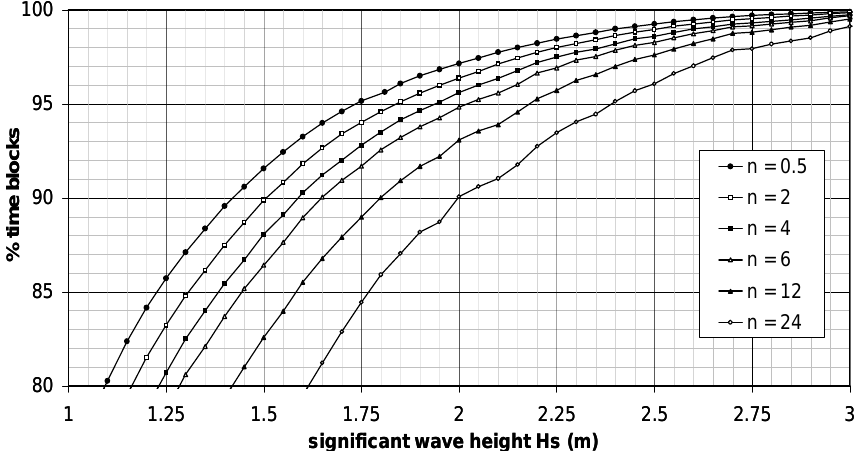
Figure 3. Bol van Heist (Wavec, 1997-2002): Percentage of n hours time blocks during which the significant wave height is not exceeded (Vantorre et al,